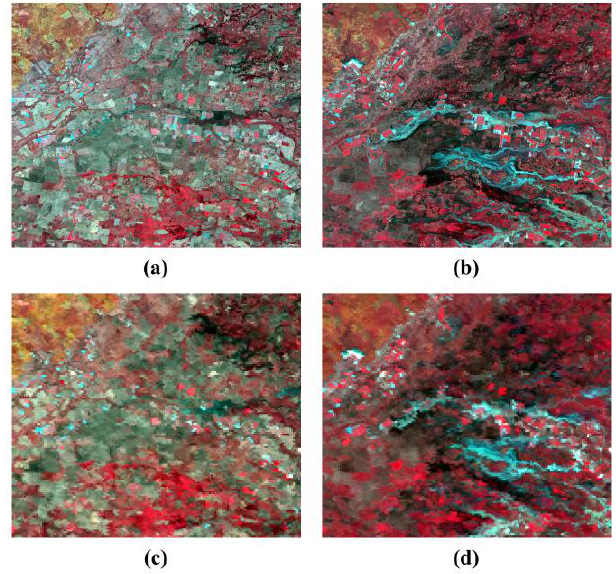
Figure 3. Dataset of the Lower Gwydir Catchment (LGC) site. ( a ) Landsat image, 26 November 2004; ( b ) Landsat image, 12 December 2004; ( c ) moderate resolution imaging spectroradiometer (MODIS) image, 26 November 2004; ( d ) MODIS image, 12 December 2004.